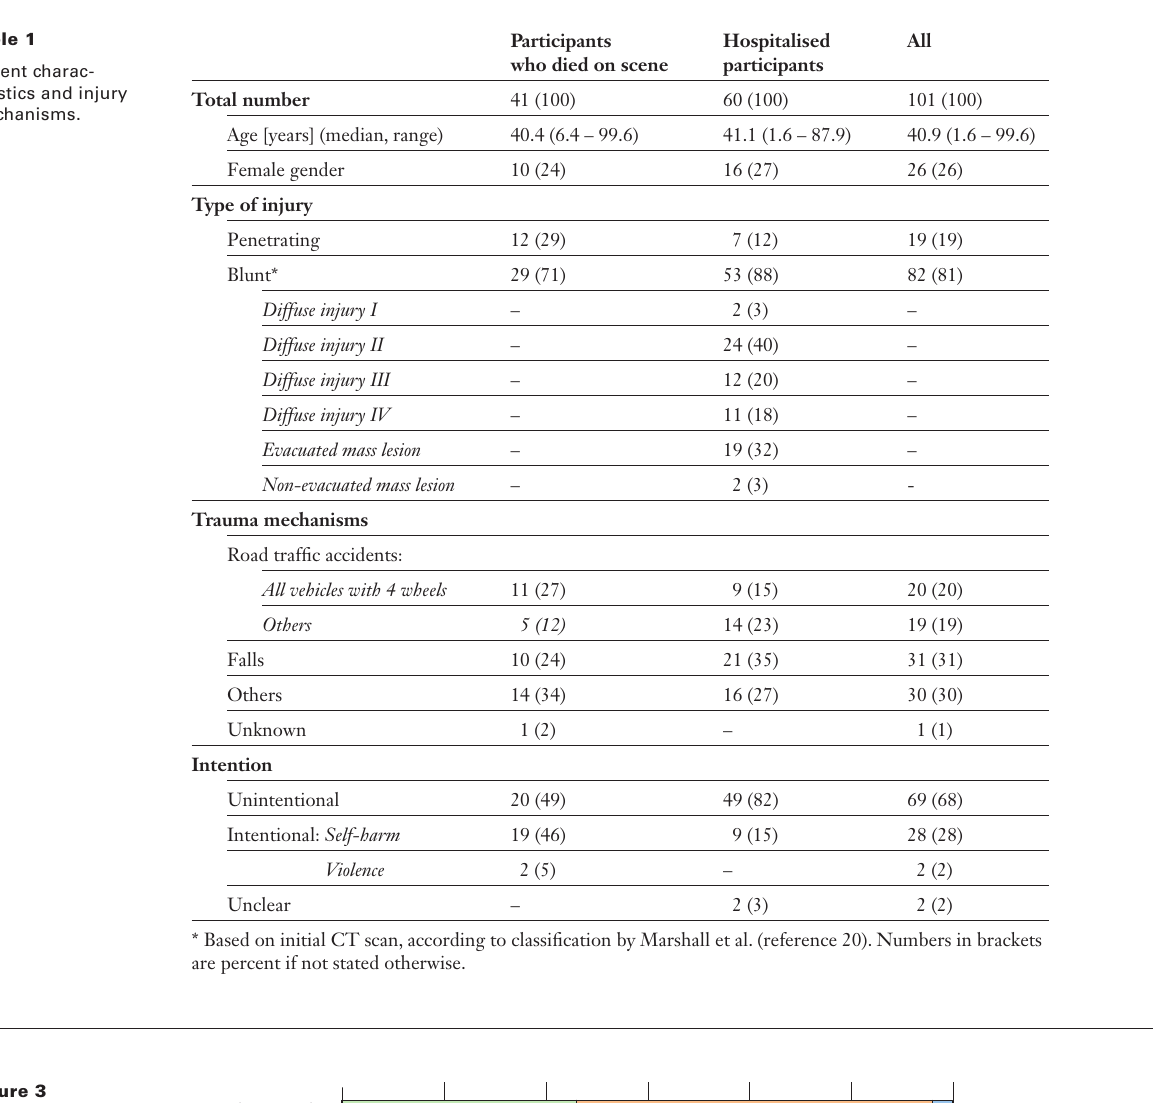
Figure 3 Injury pattern of hos- pitalised